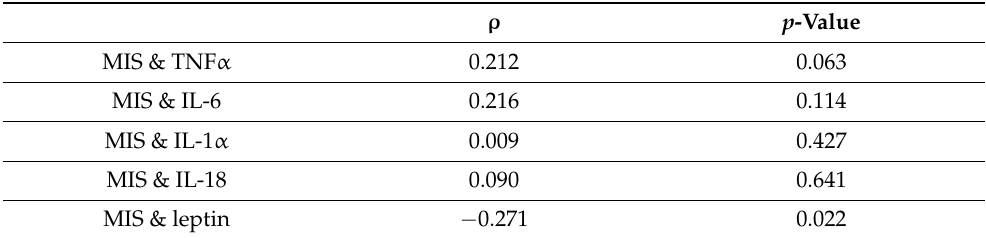
Table 9. Correlations of main cytokines in the study with MIS score. ρ p